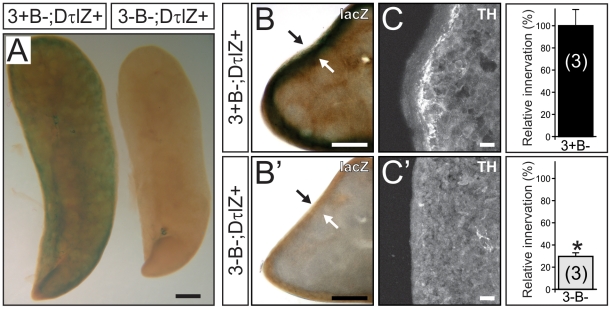
Abnormal innervation to the spleen in the absence of Egr3 and sympathetic neuron death.(A) Sympathetic innervation to the spleen was highly diminished in Egr3-deficient mice (3-B−; DτlZ+) compared to control (3+B−; DτlZ+) mice. Note the markedly decreased lacZ reaction product in the Egr3-deficient spleen (right compared to left) which correlated with decreased subcapsular (B') lacZ reaction (arrows) and (C') TH+ terminal axon innervation in Egr3-deficient mice (3-B−; DτlZ+) relative to (B, C) control (3+B−; DτlZ+) mice. In Egr3-deficient spleens sympathetic innervation was reduced by >70%. (results of TH immunofluorescence quantification representing the mean ± standard error from 3 4–8 week old mice of each genotype; * = p<0.0001, Student's t test; scale bar = A, 1 mm; B, B', 0.5 mm; C, C', 10 µm).